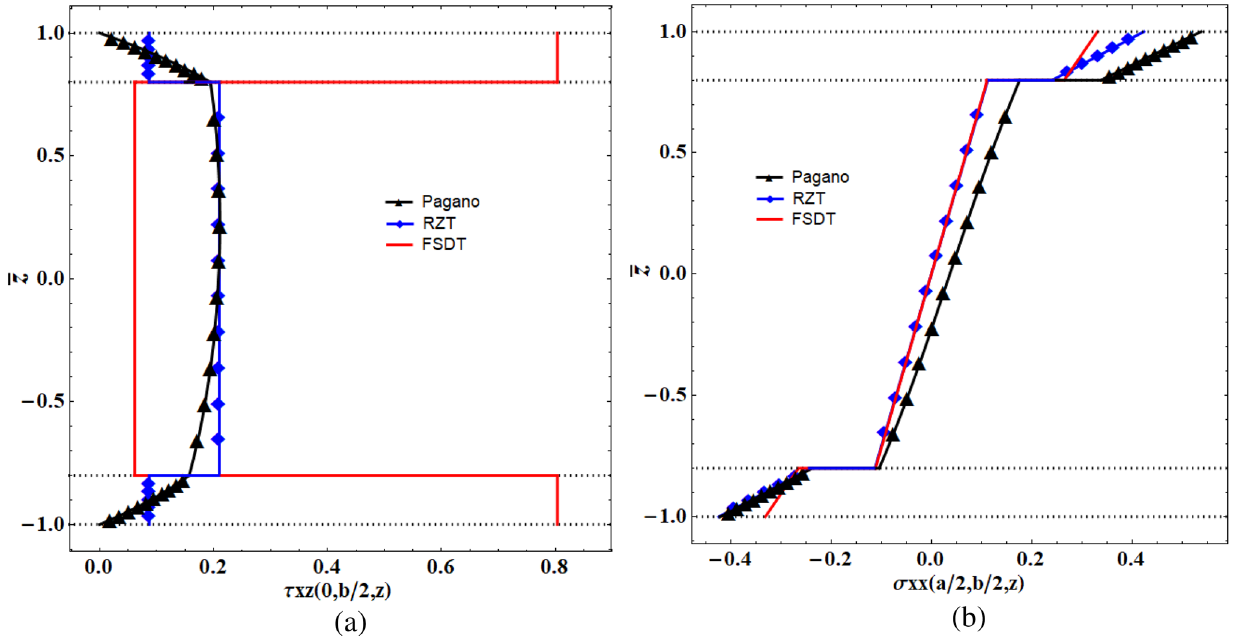
Figure 4. The variation of ( a ) shear stress, and ( b ) normal stress, along the thickness of the sandwich panel calculated using different theories.